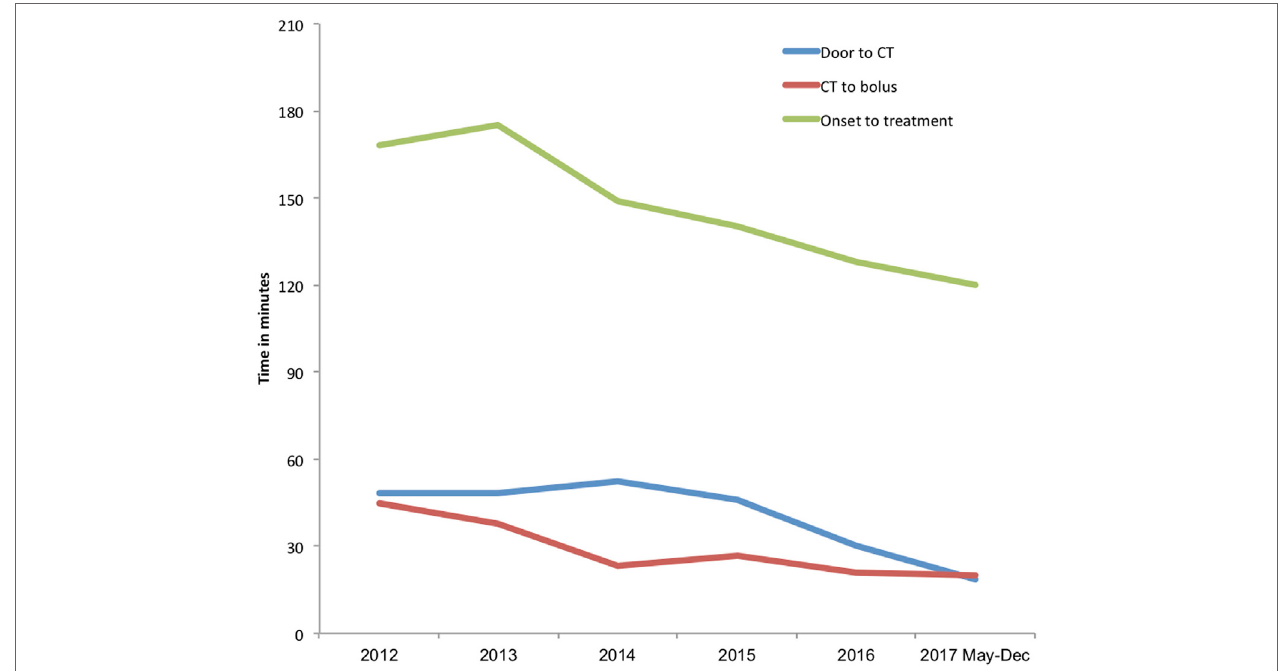
FigUre 5 | Trends in median door-to-imaging, imaging-to-treatment, and onset-to-treatment times. Annual median onset to treatment (green line), door-to-imaging (blue line), and imaging-to-treatment (red line) times in